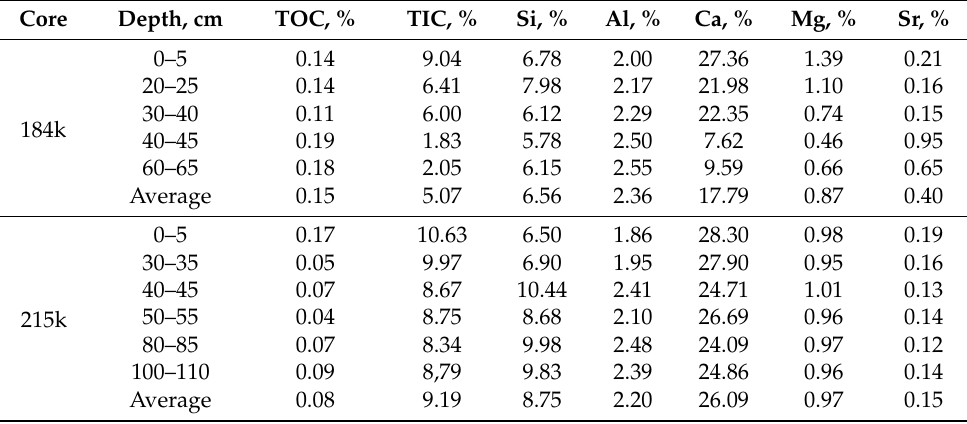
Table 1. The total organic carbon (TOC), total inorganic carbon (TIC), and some major elements in the bulk sediments of 184k and 215k cores from the hydrothermal cluster